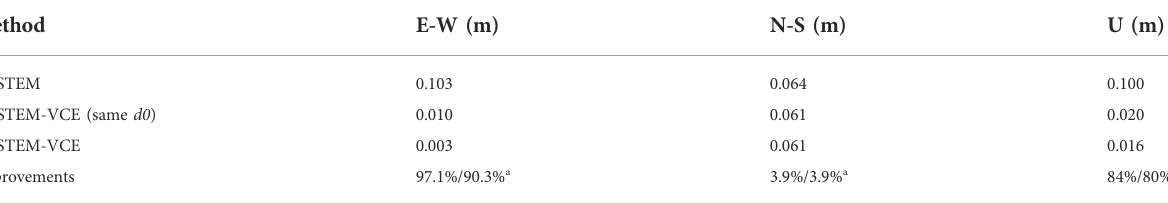
TABLE 2 The RMSEs for the EISISTEM-VCE and ESISTEM